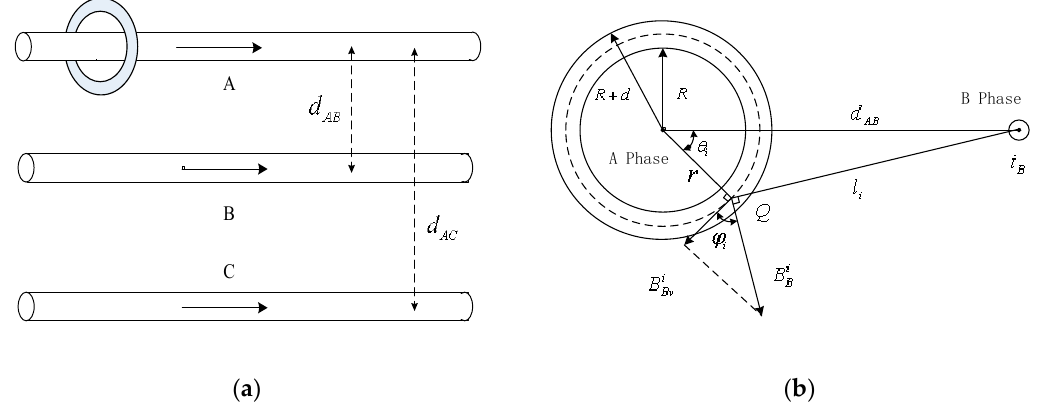
Figure 3. Interference of adjacent conductors. ( a ) Interferences of adjacent phases; ( b ) Effect of the Phase-B magnetic field.